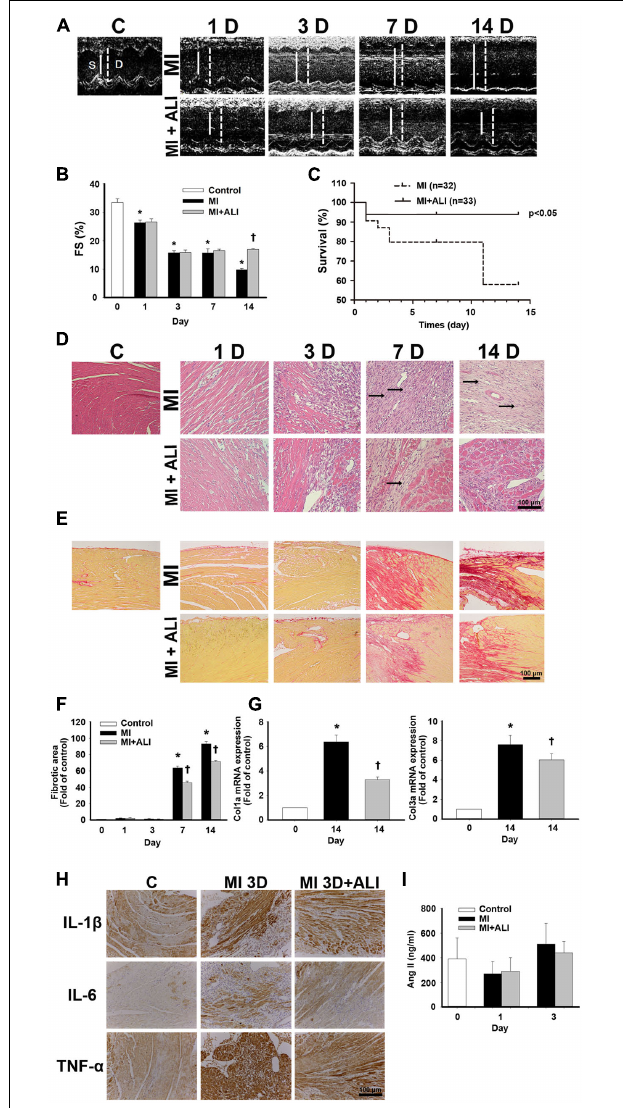
FIGURE 1 | Aliskiren treatment improves cardiac function and morphology in MI mice. (A) Representative echocardiogram from PBS-treated mice (MI, n = 6) and aliskiren-treated mice (MI + ALI, n = 6) on 1, 3, 7, and 14 days after LAD ligation. The sham-operated mice (C, n = 17) showed a normal cardiograph. (B) Quantitative data of the fractional shortening (FS). (C) Survival rate at 14 days was following myocardial infarction (MI). Kaplan–Meier analysis